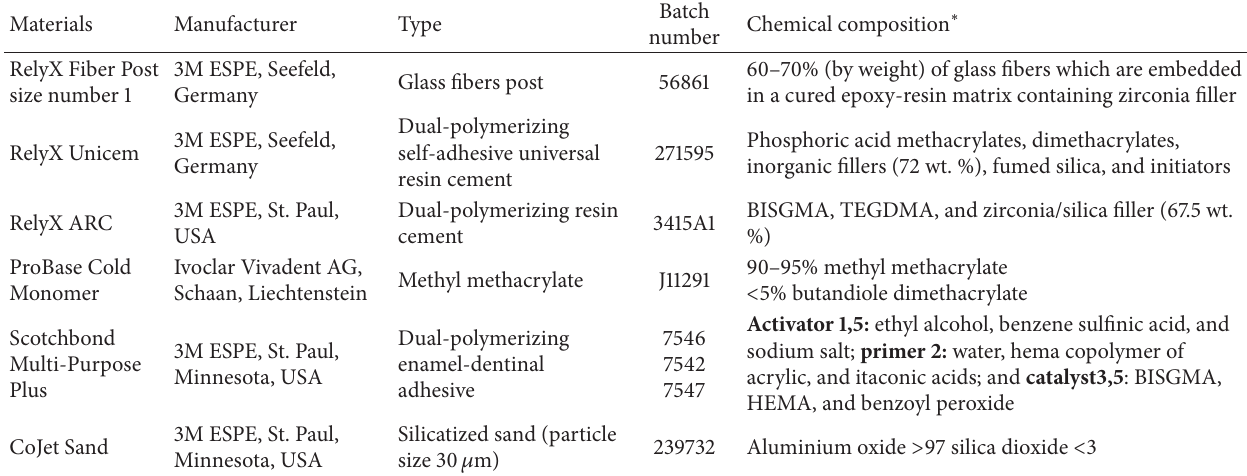
Table 1: List of materials used in this